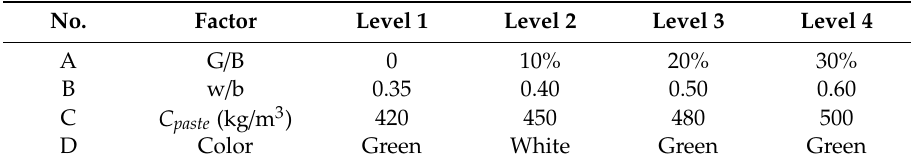
Table 5. Factors and levels used in the Taguchi experiment design.